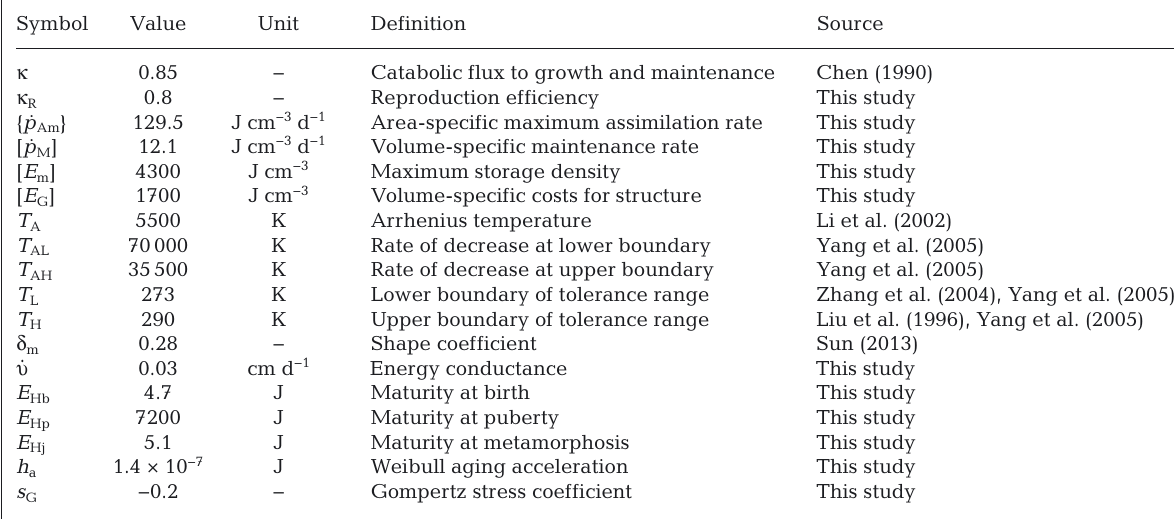
Table 2. Final dynamic energy budget (DEB) model parameters for sea cucumber Apostichopus japonicus and other parameters